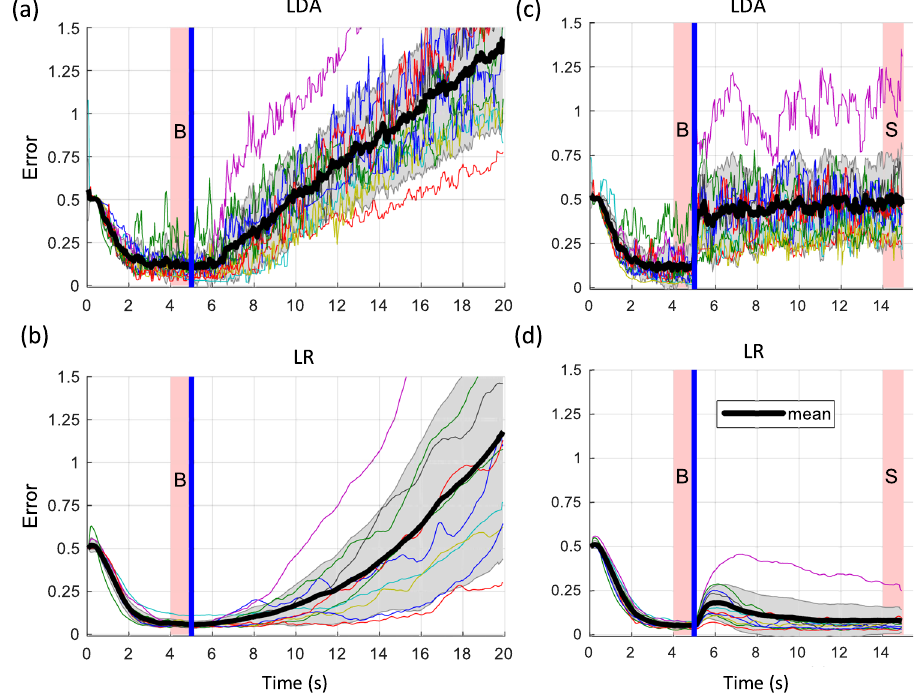
Figure 4. Closed loop control performance (online). ( a , b ) Error in reaching when linearly increasing noise was added to the signals online for LDA ( a ) and LR ( b ). ( c , d ) Error in reaching when sudden noise was added to the signals online for LDA ( c ) and LR ( d ). The plots show the error for each subject and the mean and standard deviation across all subjects, for LDA ( a ) and LR ( b ). The plots show the error for each subject, the mean (black lines) and standard deviation (grey area is ± SD) across all subjects. The blue line indicates the beginning of the interval when the artificial noise was added and the pink shaded areas labelled with “B” and “S” mark the periods when the baseline error and the error with noise were extracted.